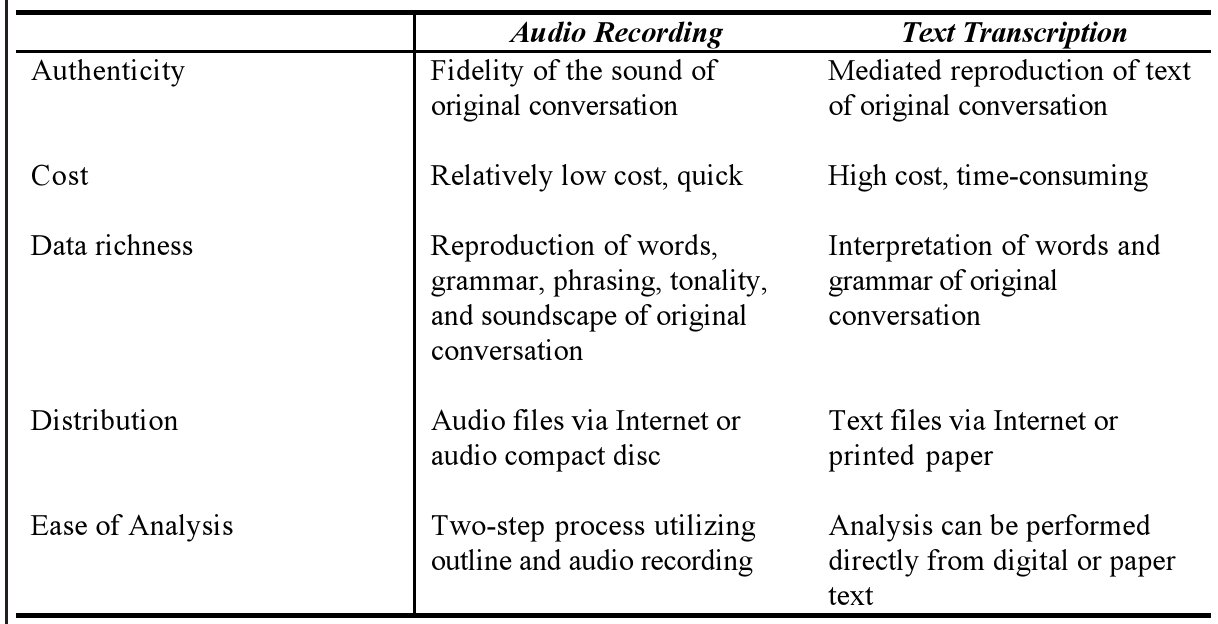
Table 2. Comparison of Audio Recording and Text